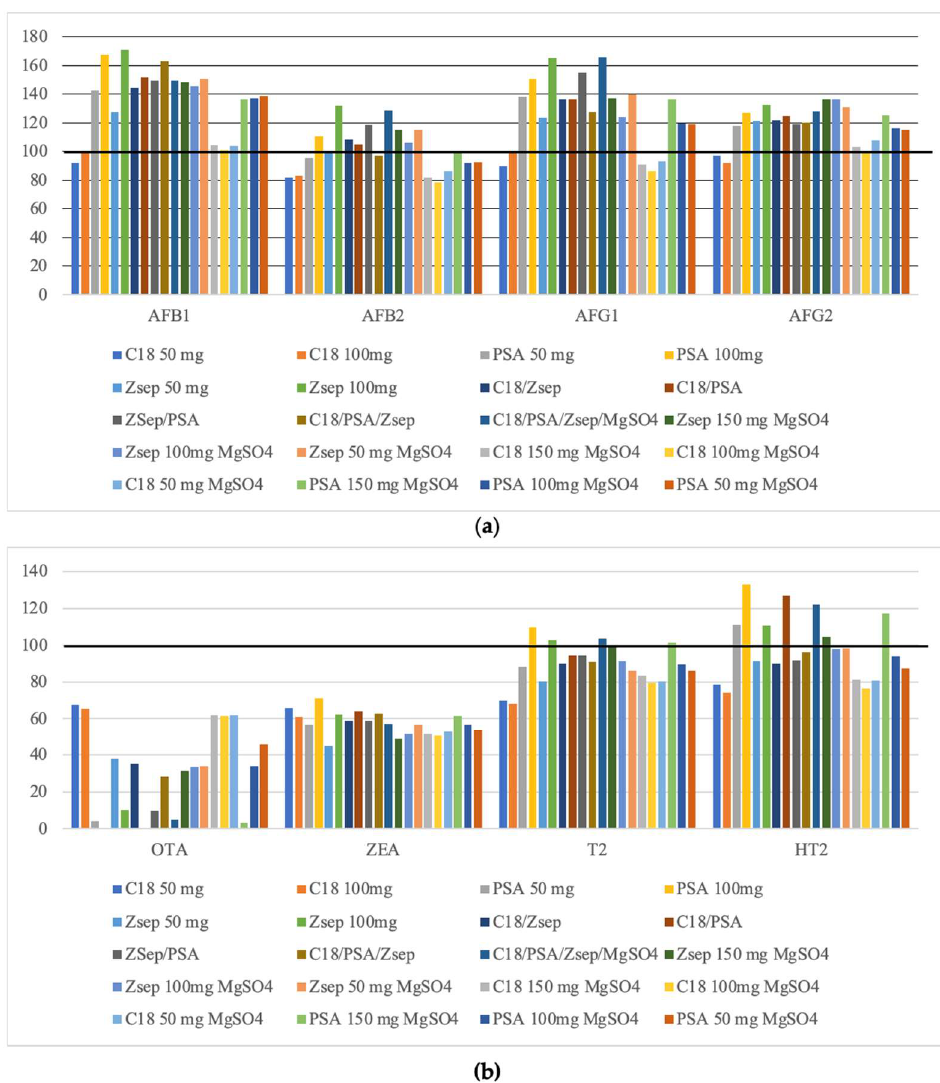
Figure 4. Effect of different sorbents in dispersive solid-phase extraction (d-SPE) clean-up, considering peak areas from enhanced matrix removal-lipid (EMR-Lipid) for comparison (100%) of ( a ) AFs (AFB1–Aflatoxin B1; AFB2–Aflatoxin B2; AFG1–Aflatoxin G1; AFG2–Aflatoxin G2) and ( b ) Ochratoxin A (OTA), Zearalenone (ZEA) and toxin HT-2